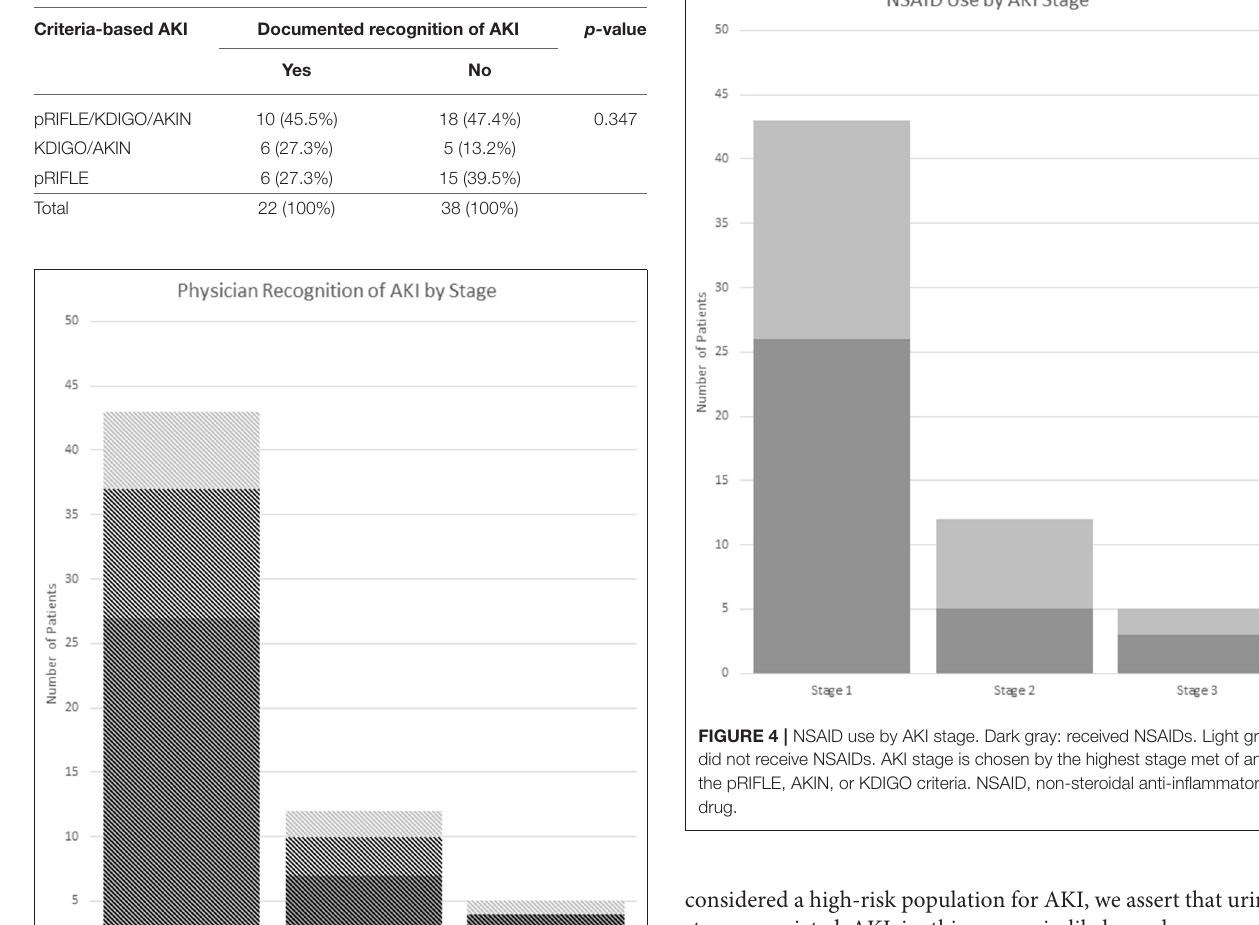
stones accounted for 30% of AKI in a single-center Pakistani cohort (12).